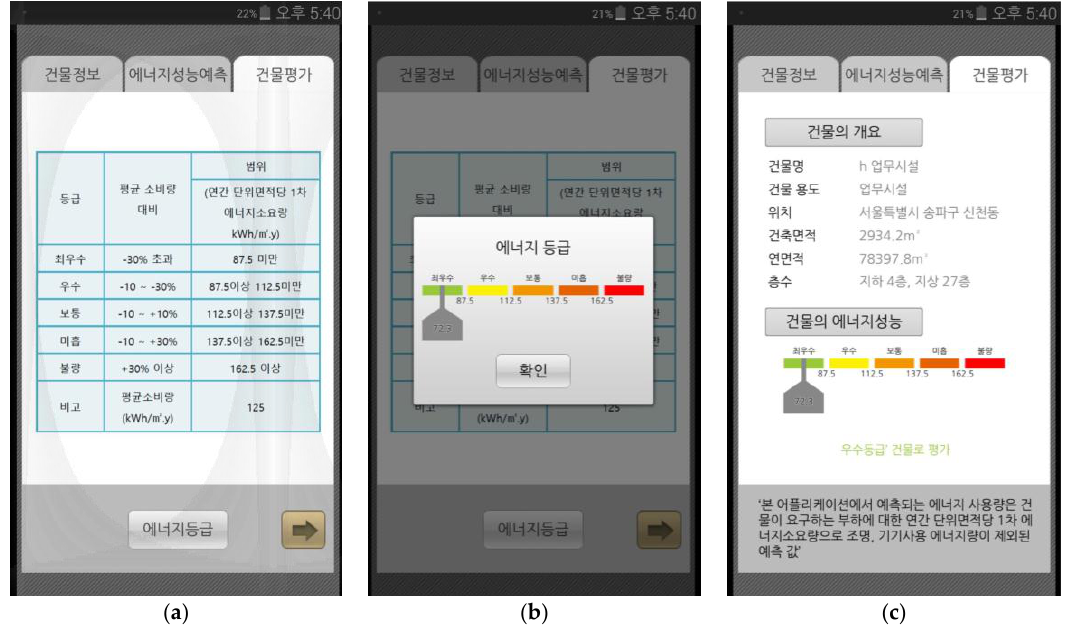
Figure 7. ( a ) Energy total; ( b ) energy performance level; and ( c ) final result.